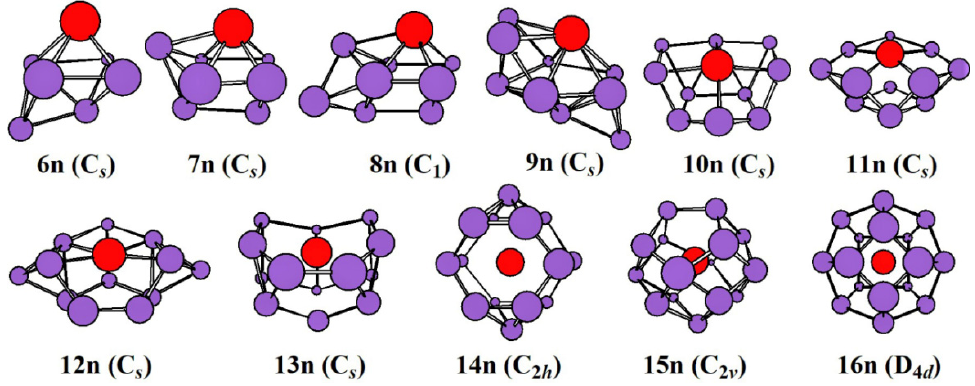
Figure 1. The lowest-energy structures of ZrSi n ( n = 6–16) and their point group.